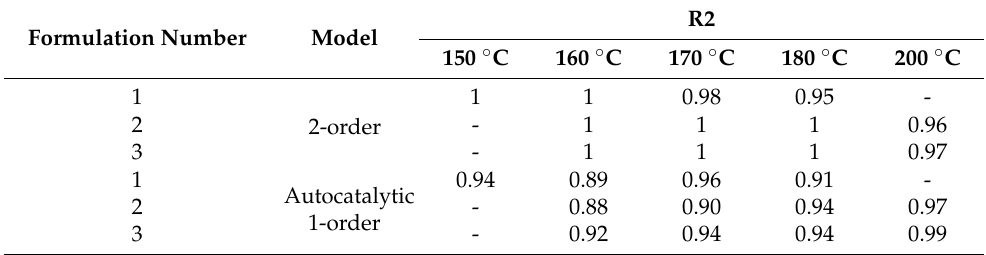
Table 3. The values of R2 according to the 2-order equation for formulations 1–3. Formulation